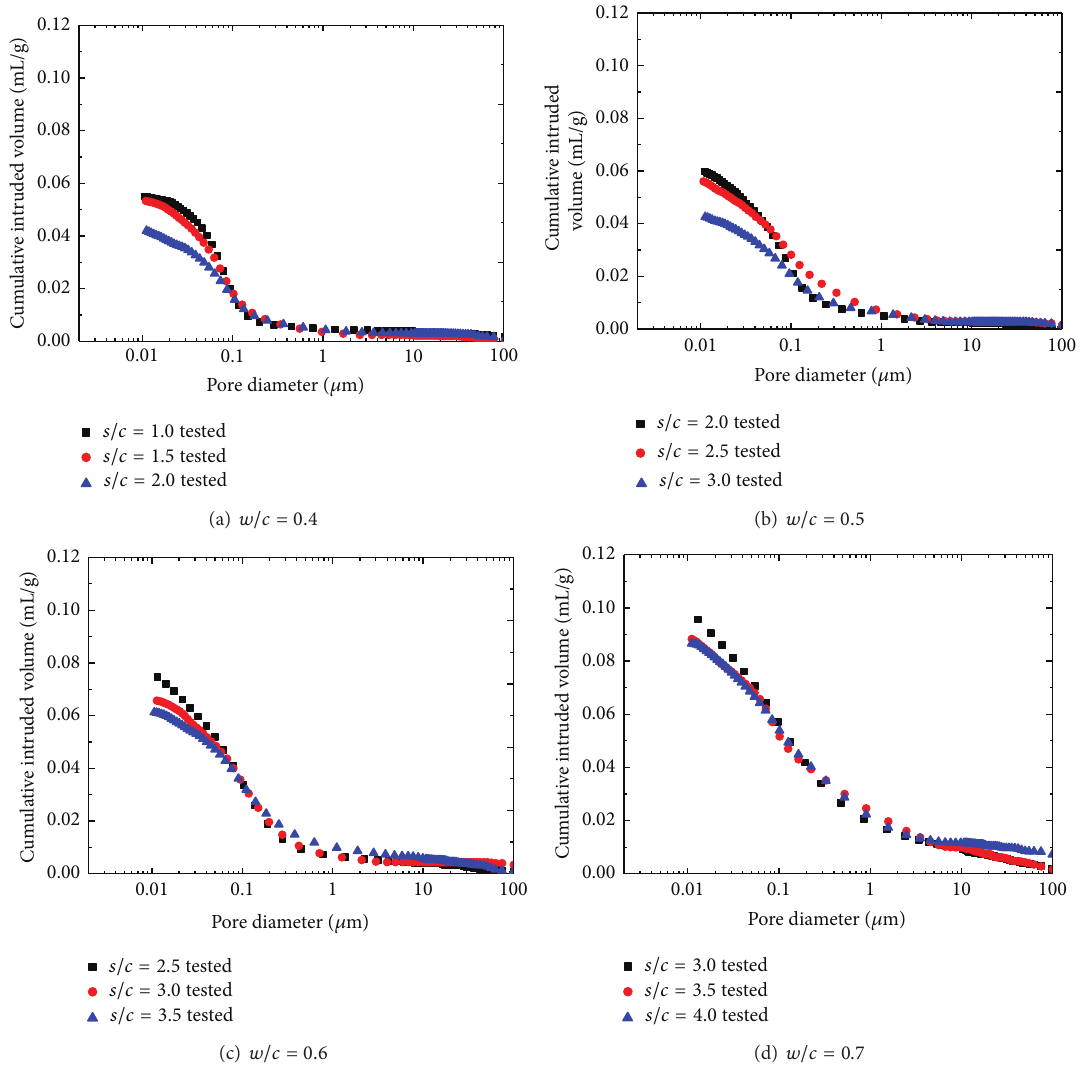
Figure 4: Cumulative intruded pore volume versus pore diameter for NS